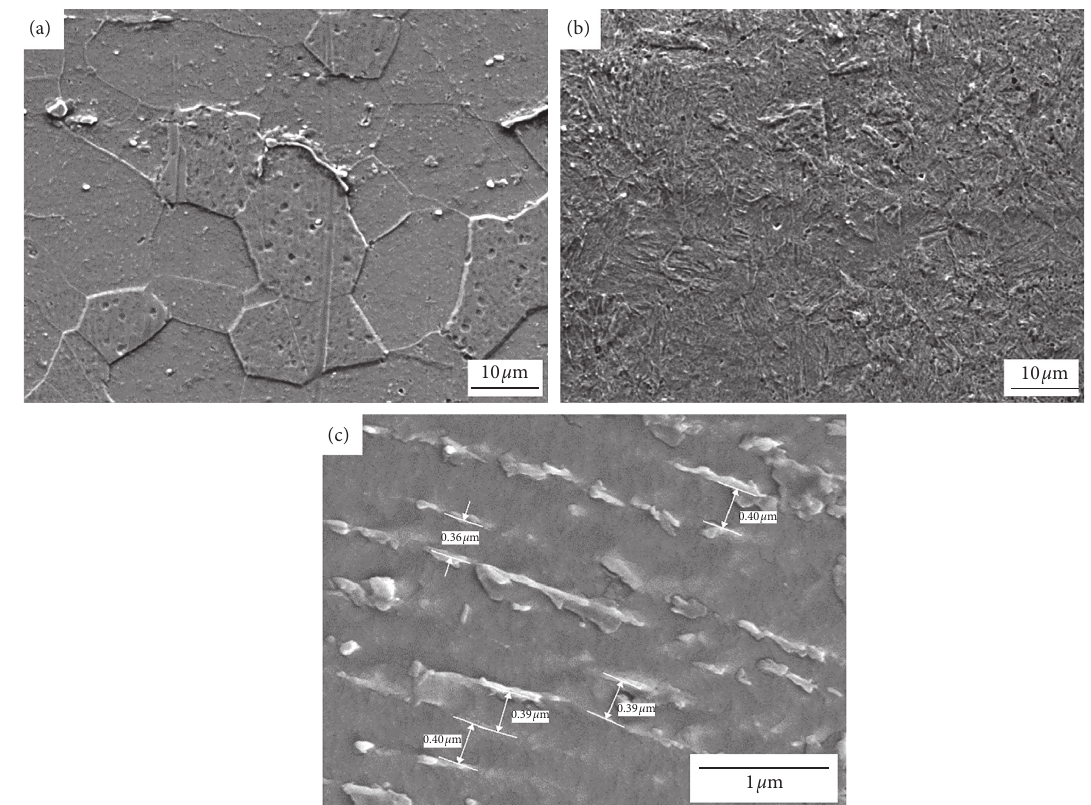
Figure 7: Microstructure of steel: (a) untreated area of steel with ferrite-pearlite structure (65% ferrite and 35% pearlite according to GOST 8233-56 [40], grain size G8 according to ISO 643:2012 [42], magnification × 1500), (b) laser-treated layer (dispersed sorbite structure, grain size G11 according to ISO 643:2012 [42], magnification × 1500), and (c) laser-treated layer (dispersed sorbite structure, according to GOST 8233-56 [40], magnification × 20000).